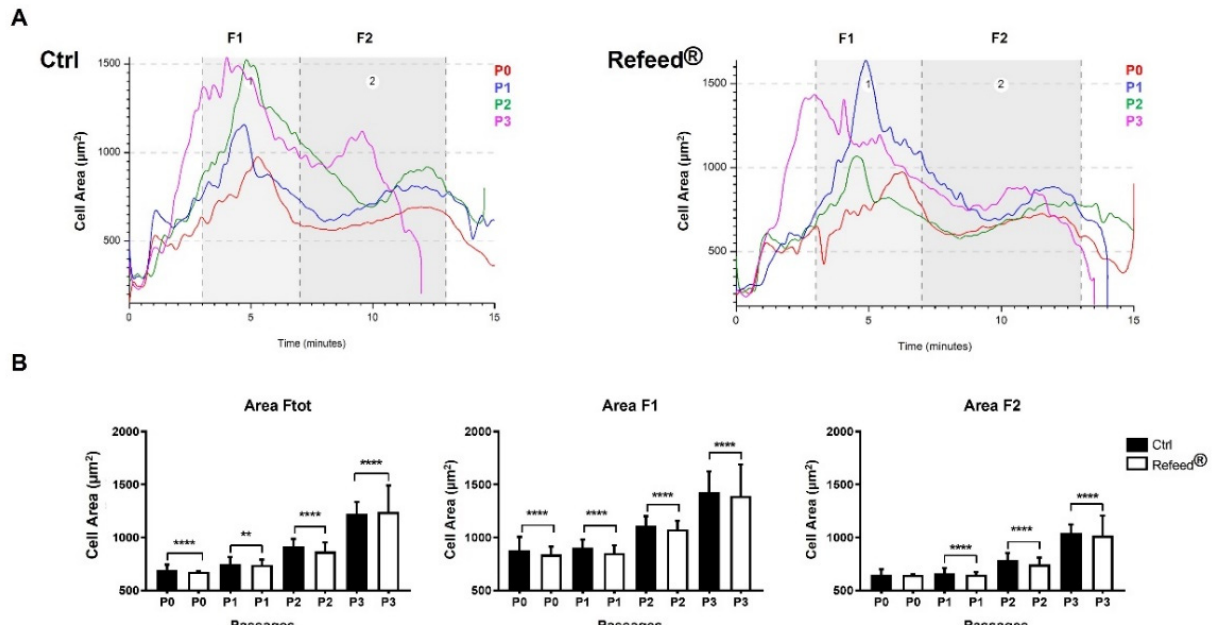
Figure 6. Analysis of human Amniotic Epithelial Cells (hAECs) area using Celector ® technology. ( A ) Dimensional profile of hAECs cultured in basal medium (Ctrl) and with Refeed ® supplement during passages P0–P3. Curves represent the cell area ( µ m 2 ) vs. the time of analysis (minutes). Two sub-populations, F1 and F2, were underlined and further dimensional analysis were carried on following these time intervals. ( B ) Column graphs represent the cell area of hAECs for each passage in the whole population (F tot) and in subpopulations (F1 and F2) that were examined. Data are expressed as mean ± standard deviation (SD) (** p < 0.01, **** p < 0.0001). The experiment was performed on three human samples in technical triplicate.